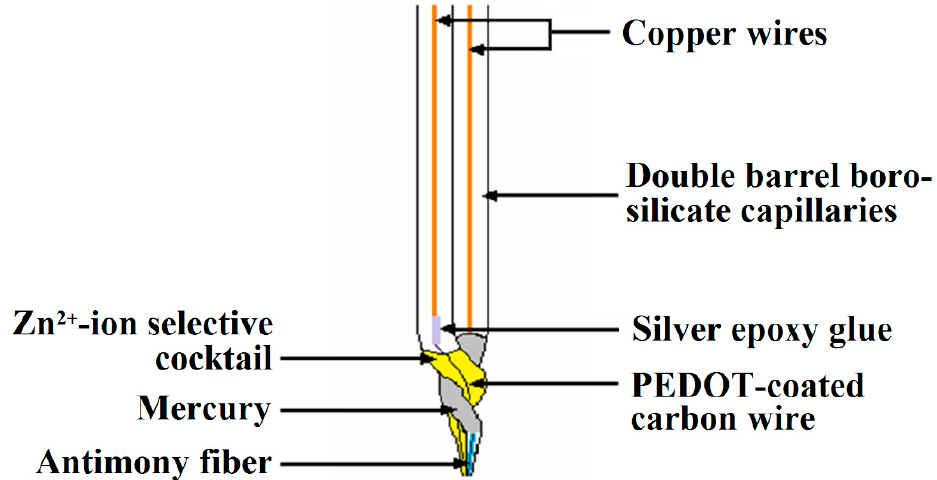
Figure 4. Schematic of the double-barrel Zn-ISME/Sb probe for combined potentiometric detection of Zn(II) ion concentration and pH distributions in the SECM.